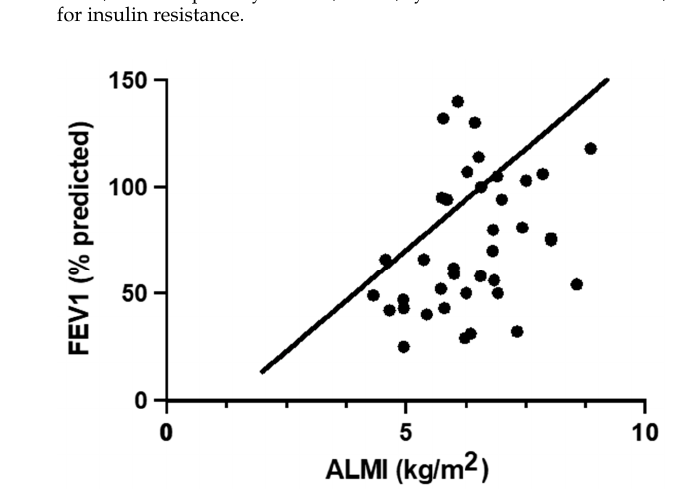
Table 4 outlines the results of the correlation analysis between DXA body composi- tion measures, dietary intake components, and physical activity scores. Multiple measures of body fat composition, particularly fat mass, % fat, and FMI, negatively correlated with total amount of macronutrients (energy, fat, carbohydrate and protein), though the rela- tive proportion of each macronutrient intake did not correlate with body composition. Added sugar and glycemic load both negatively correlated with multiple measures of